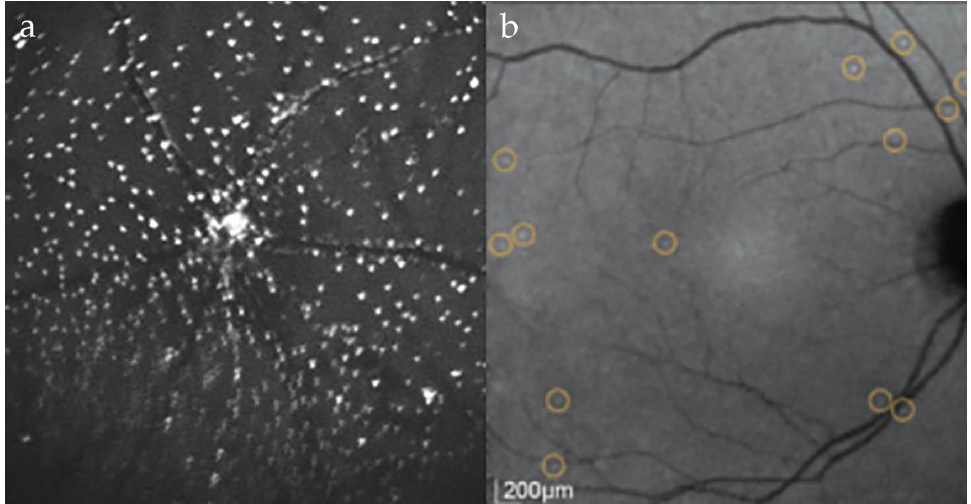
Figure 1. DARC imaging highlighting apoptosing retinal ganglion cells ( a ) using intravitreal ANX776 in a rat model of glaucoma following episcleral vein injections of hypertonic saline; ( b ) using intravenous ANX776 in a human glaucoma patient shown to have progressive disease.